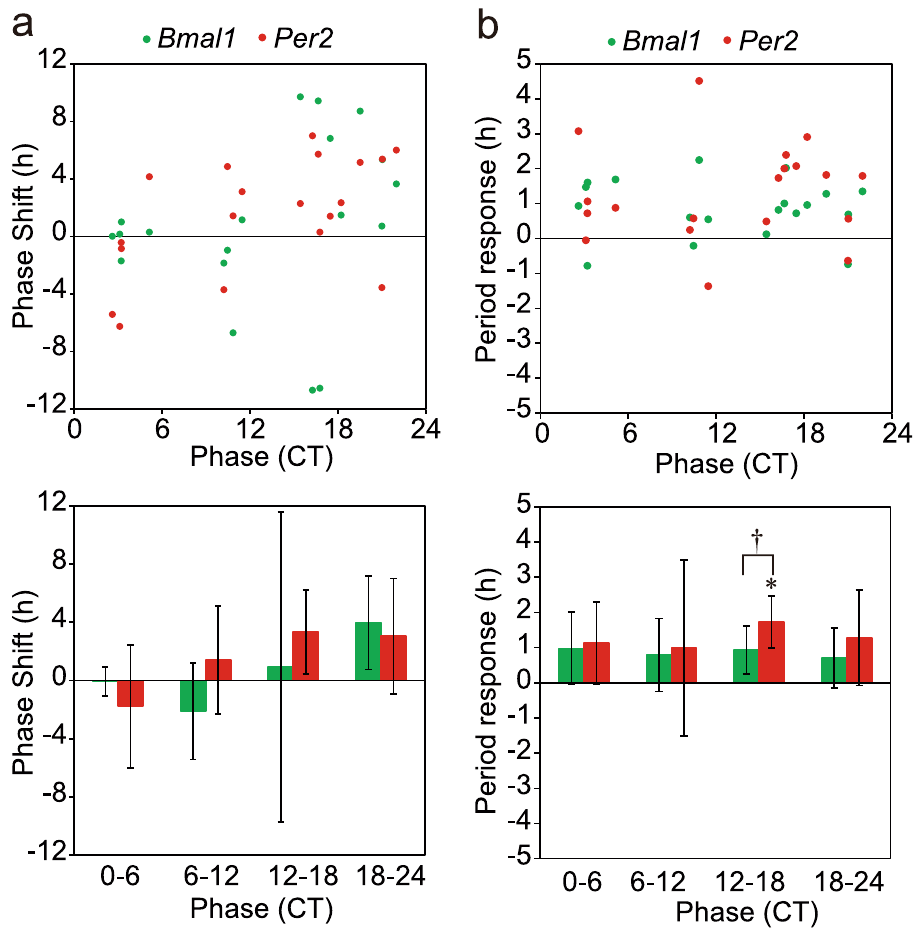
Figure 7. Phase-response curve and period-response curve for medium exchange in the adult SCN pretreated with TTX ( a ). Phase-responses (n = 19) of circadian Bmal1 (green circle) and Per2 (red circle) rhythms in the adult SCN (upper panel). The SCN was pretreated with TTX (see text). Mean phase-shifts with SD at CT0–CT6 (n = 5), CT6–CT12 (n = 4), CT12–CT18 (n = 5) and CT18–CT20 (n = 5) (lower panel). See also the legend for Fig. 4a. ( b ) Period-responses obtained from the same experiment as ( a ). Period-responses in individual slices of circadian Bmal1 (green circle) and Per2 (red circle) (upper), and the mean responses with SD at the 4 circadian phases (lower). A significant period-response is indicated with asterisk ( * ) and a significant difference in the response between the two circadian rhythms is shown with dagger ( † ). * p < 0.05, † p <